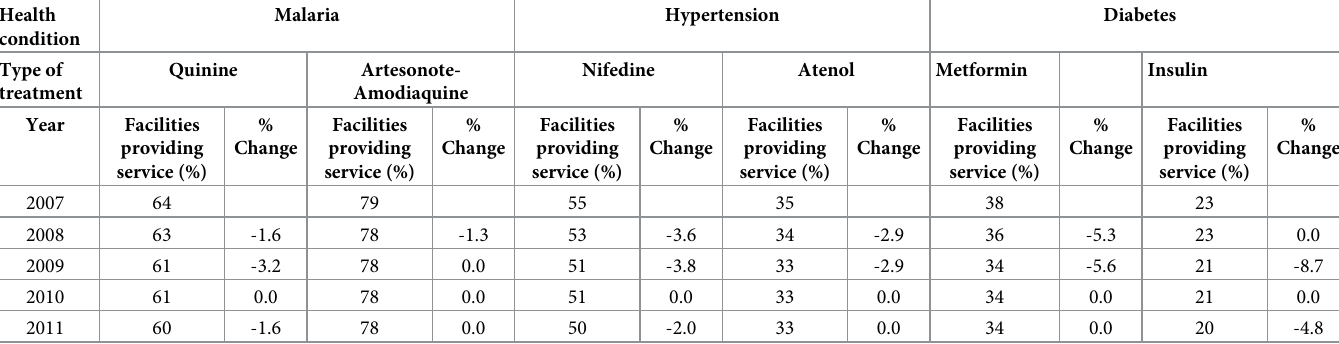
Table 4. Trends in malaria, hypertension and diabetes treatment services at health facilities in Ghana,